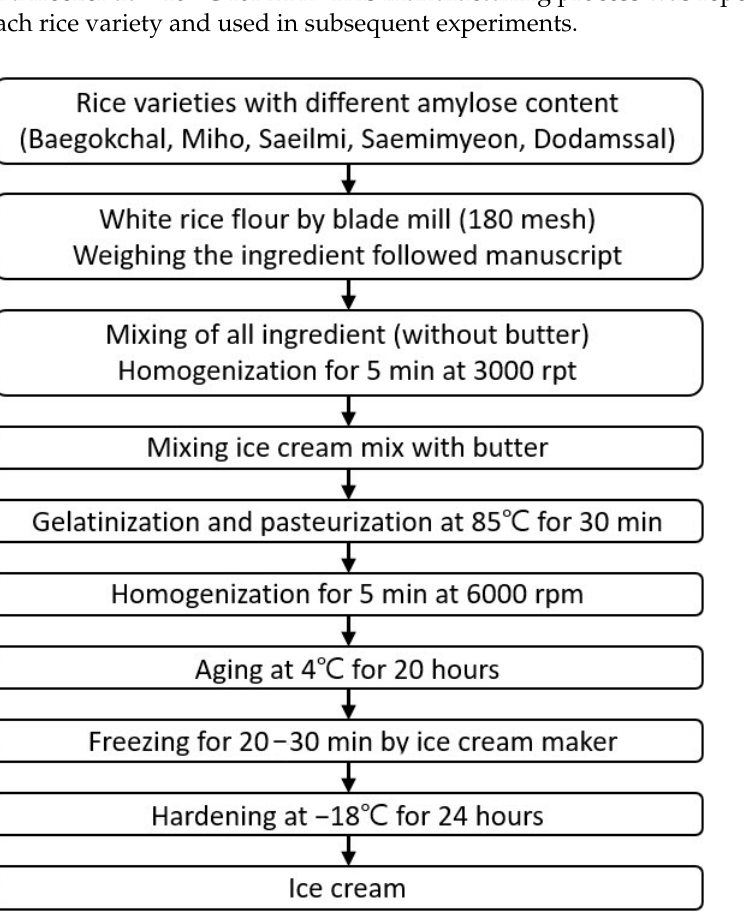
Figure 1. Schematic process flow diagram of ice cream preparation.